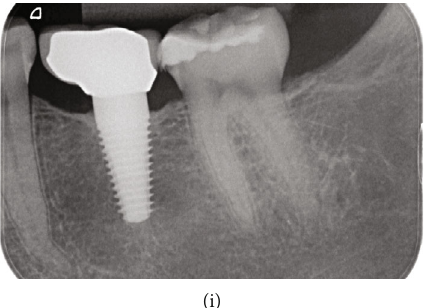
Figure 4: Prosthetic work fl ow for the one-piece implant FairOne ™ : (a) clinical situation presurgically presenting su ffi cient keratinized gingiva around implant site; (b) clinical situation after healing period of 12 weeks; (c) impression with double-mix technique; (d) laboratory processing, master cast with implant analog, and gingival mask; (e) clinical preparation using a transfer coping for occlusal adaption; (f) clinical situation with cemented implant crown (mesial pontic design); (g) postoperative radiographic control after delayed implantation; (h) radiographic evaluation four months after prosthetic restoration; (i) radiographic control nine years after implant